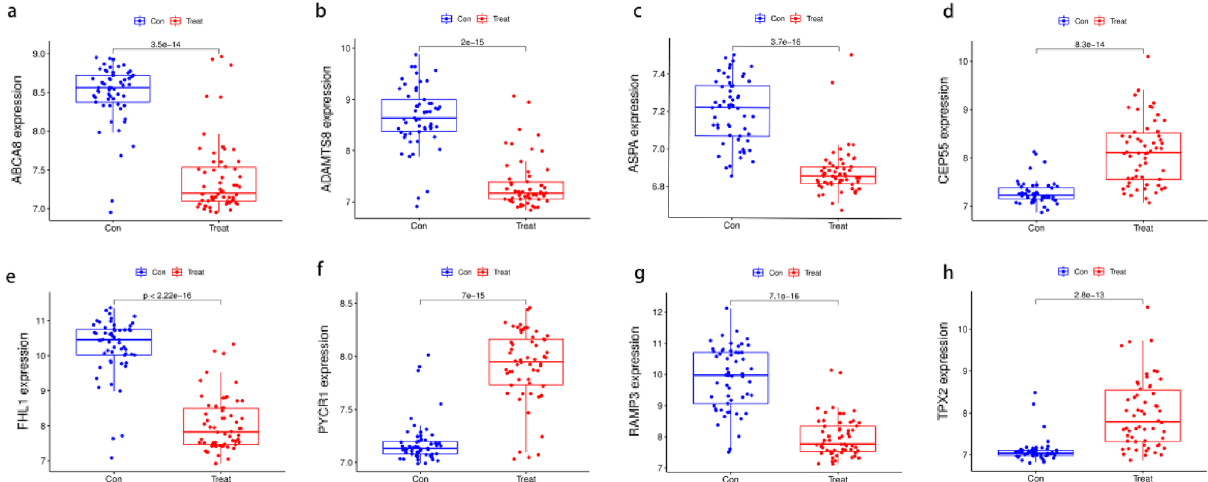
Figure 5. Expression of eight biomarkers in the validation group (GSE32863). ( a ) ABCA8. ( b ) ADAMTS8. ( c ) ASPA. ( d ) CEP55. ( e ) FHL1. ( f ) PYCR1. ( g ) RAMP3. ( h ) TPX2. P < 0.05 means difference is statistically significant.